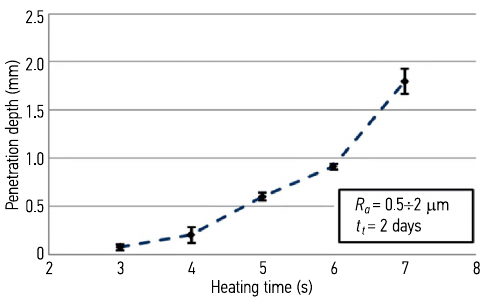
Fig. 6. Effect of heating time on penetration depth